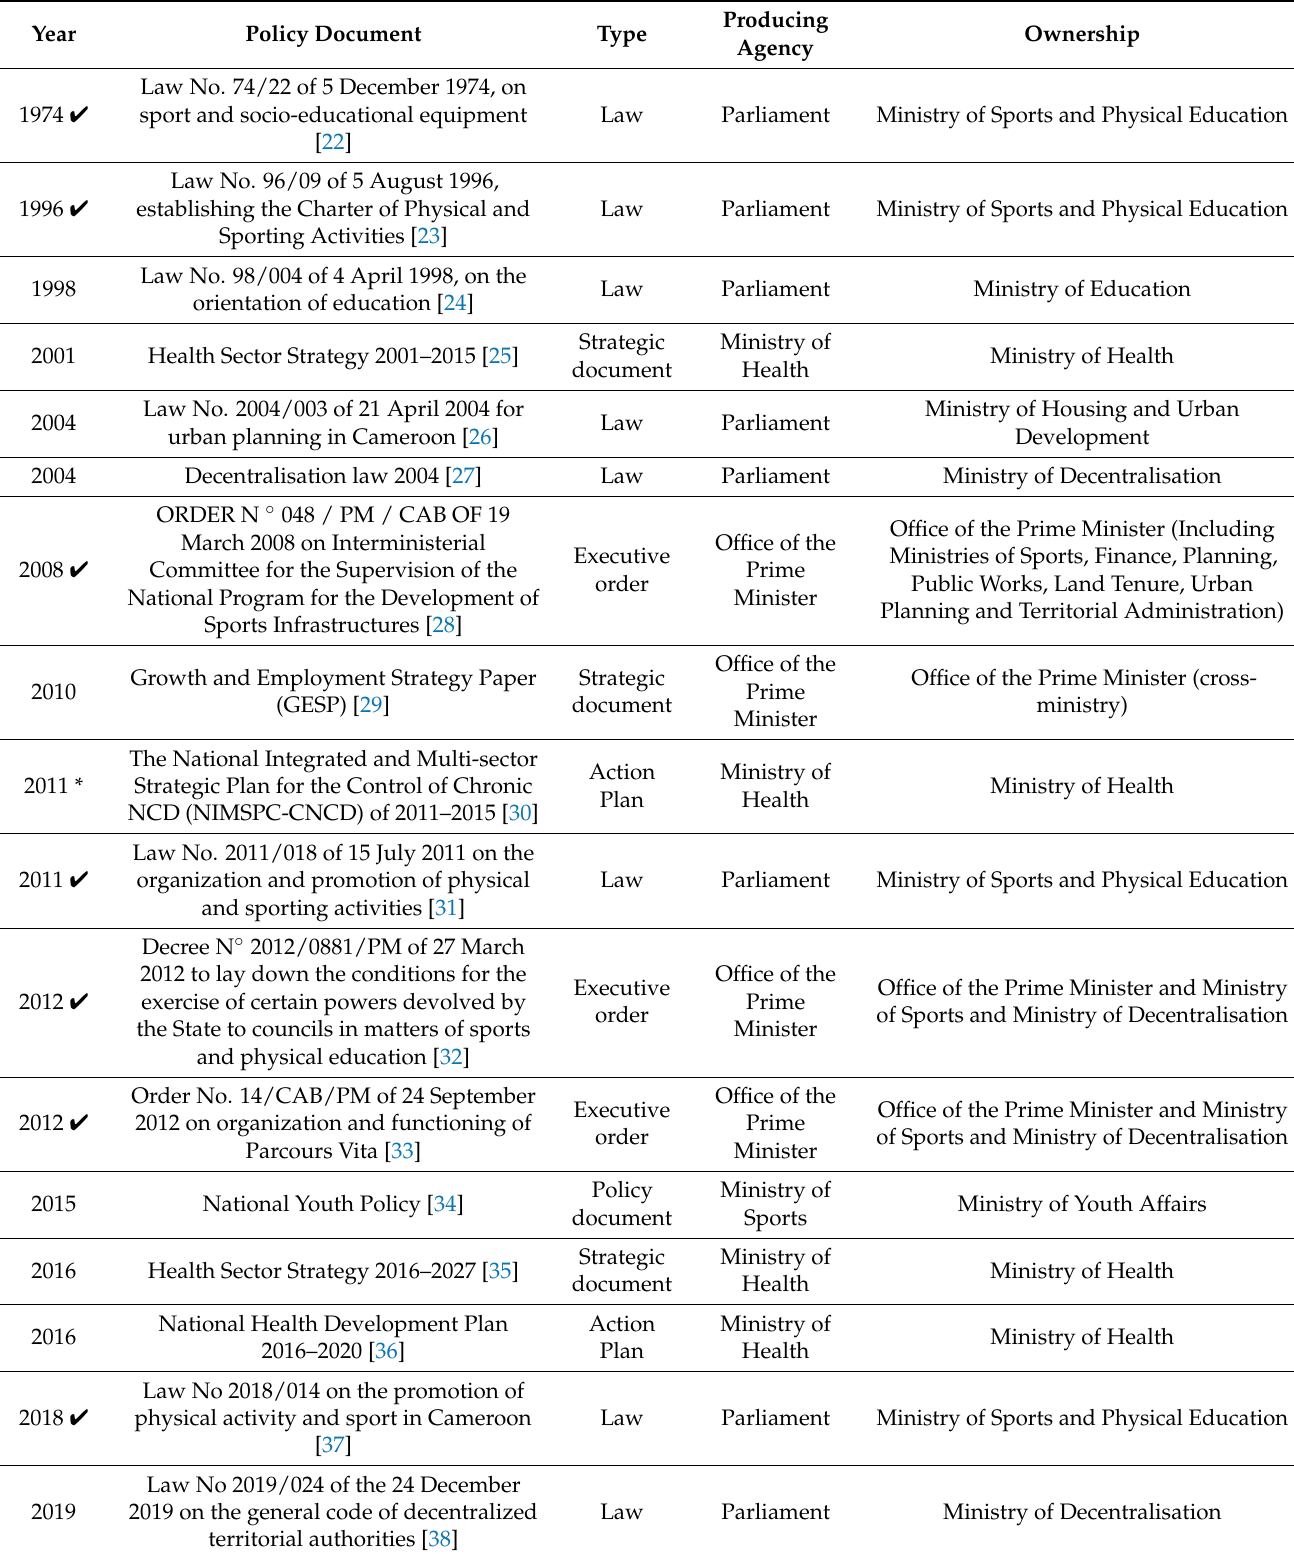
Table 1. Physical activity related policy documents in Cameroon (until